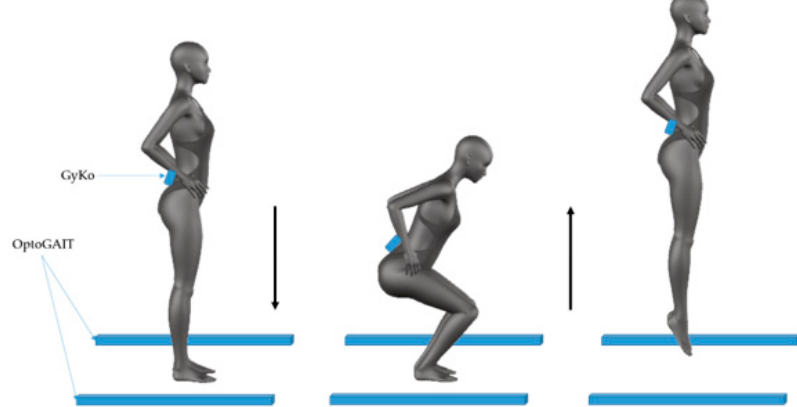
Figure 6. Jump test: subject and sensor position and sequence of movements.